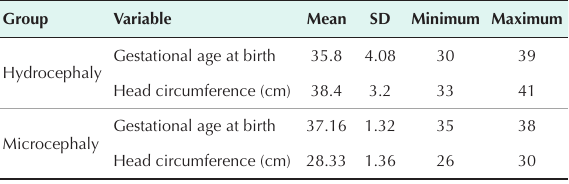
Table 3 . Head Circumference and Gestational Age at Birth